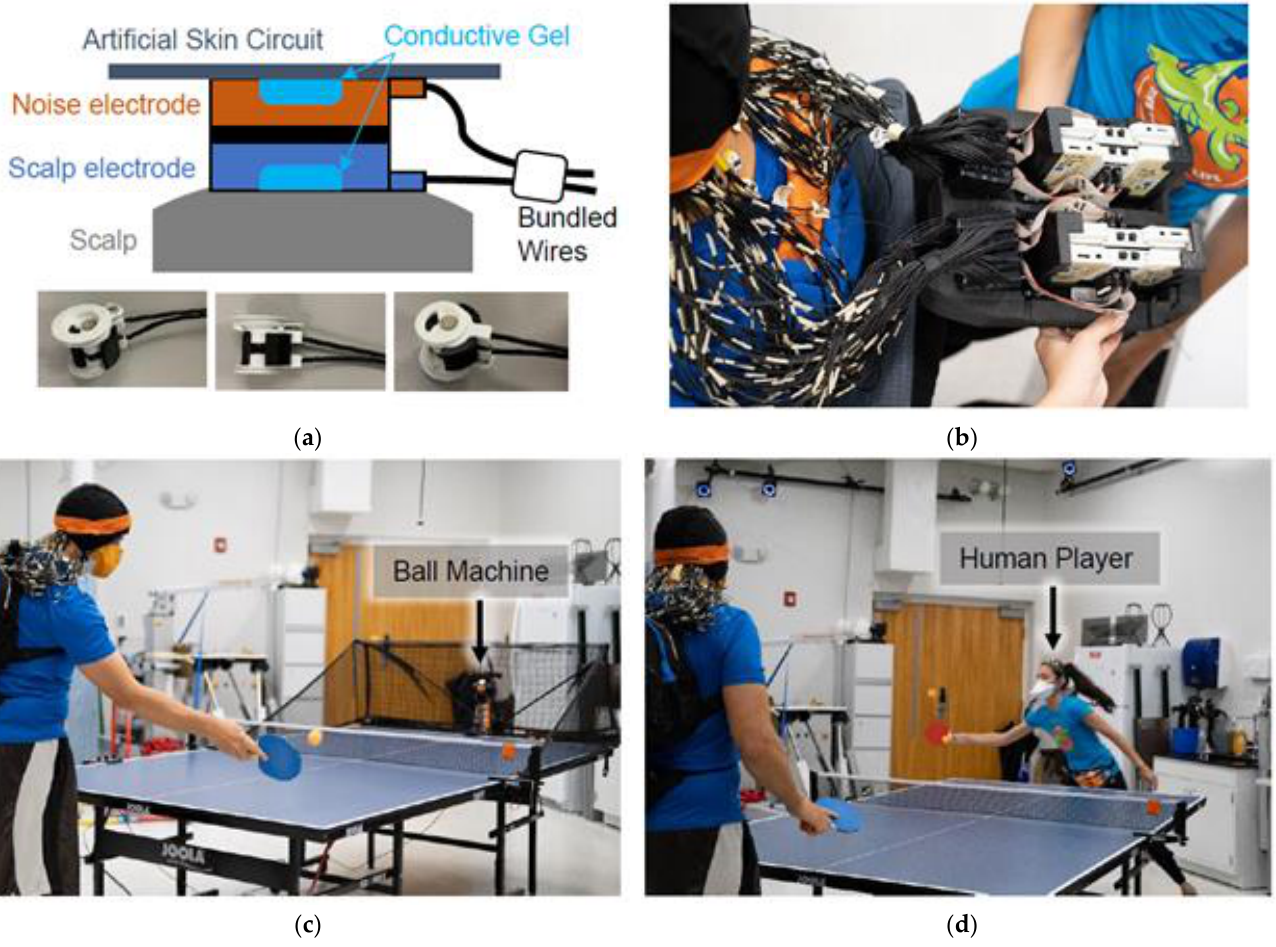
Figure 1. Table tennis experiment. ( a ) Dual-layer EEG approach. ( b ) The custom backpack insert for BrainVision amplifiers. ( c ) Stationary and moving hitting conditions with a ball machine. ( d ) Cooperative and competitive conditions with a human player.